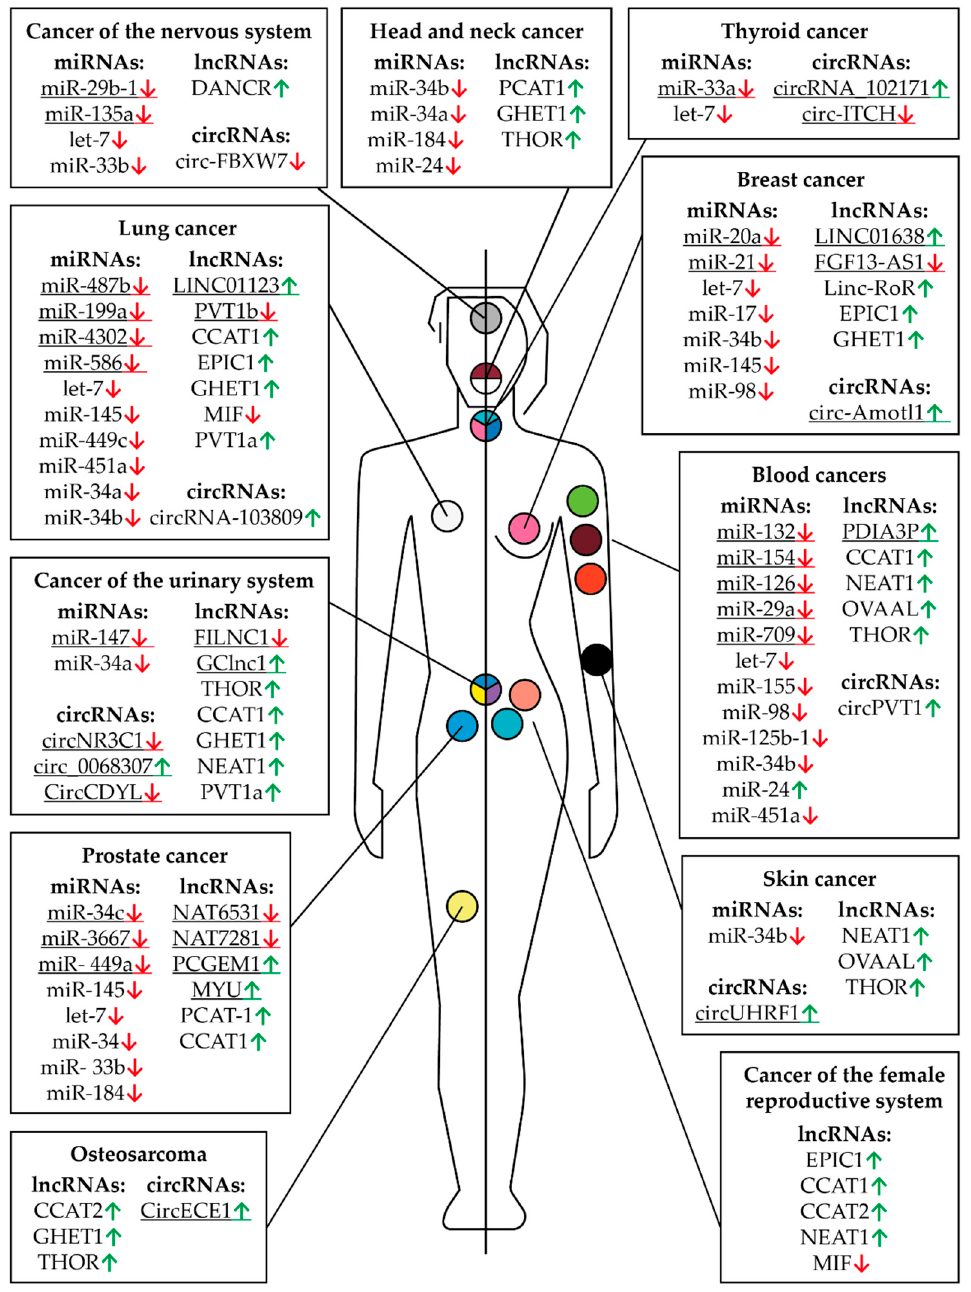
Figure 6. Controlling MYC RNAs in different types of cancer except those of the digestive system. The fields indicate miRNAs, lncRNAs, and circRNAs that have altered expression compared to healthy tissues in a particular cancer. Arrows indicate an increased (green) or decreased (red) level of RNA in a particular type of cancer. The human body (the left part is a male, the right part is female) and the location of cancer tumors are presented schematically. The colored circles indicate a particular type of cancer: burgundy—multiple myeloma, orange—leukemia, pink—breast cancer, peach—uterine or endometrial cancer, yellow—sarcoma or bone cancer, lime green—non-Hodgkin lymphoma, teal—ovarian cancer, light blue—prostate cancer, black—skin cancer, gray—brain cancer, white—lung cancer, blue, yellow, and purple—bladder cancer, blue, pink, and teal—thyroid cancer, white and burgundy—head and neck cancer. The underlined RNAs are currently believed to be tissue specific but new roles can potentially be discovered.